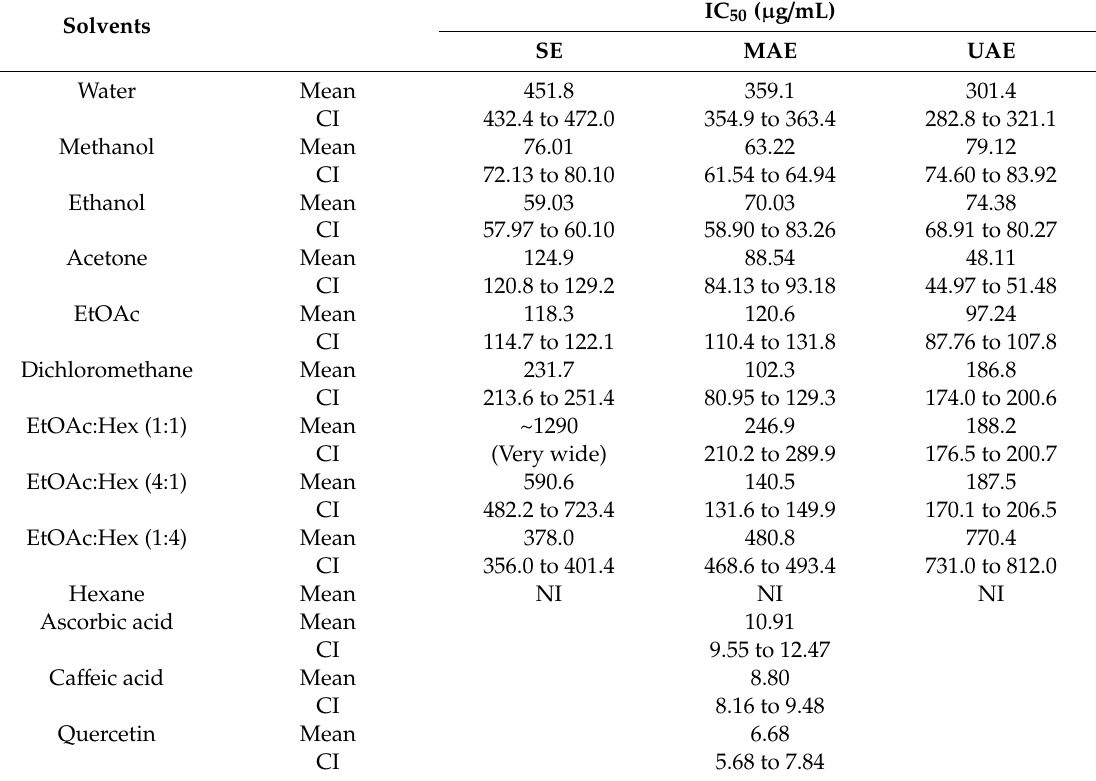
Table 2. Antioxidant activity of propolis extracts measured by free radicals